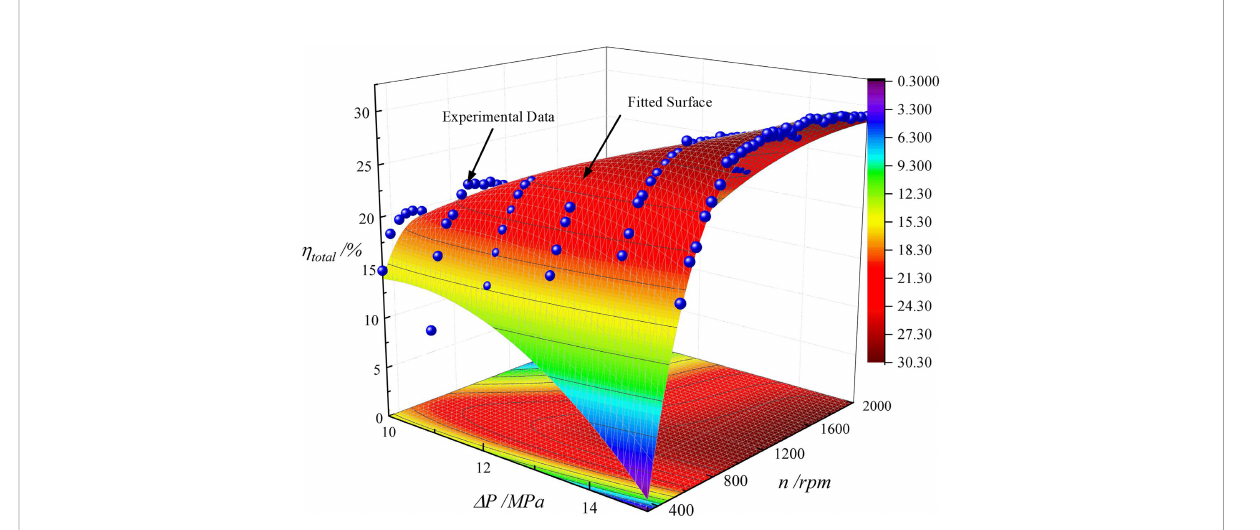
FIGURE 11 The experimental data and fi tting results for the total ef fi ciency of energy conversion system.